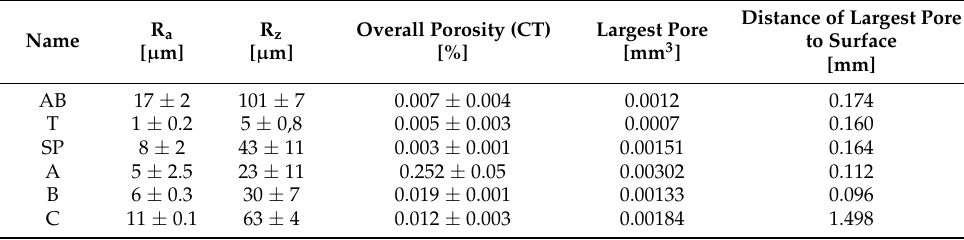
Table 6. Results of the roughness measurements and overall porosity measurement via